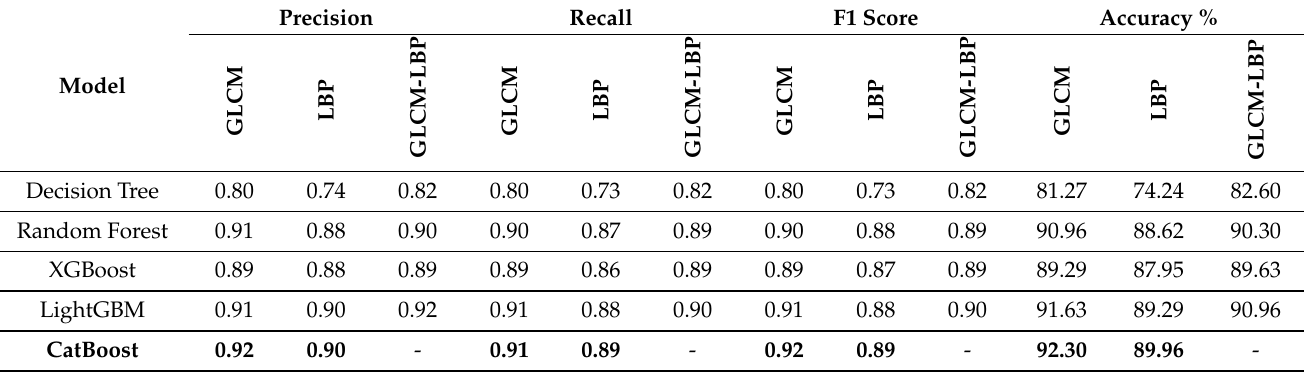
74.24% on LBP texture images, and 82.60% on combined texture GLCM-LBP images. Table 7. Performance comparison for Decision Tree, Random Forest, LightGBM, XGBoost,